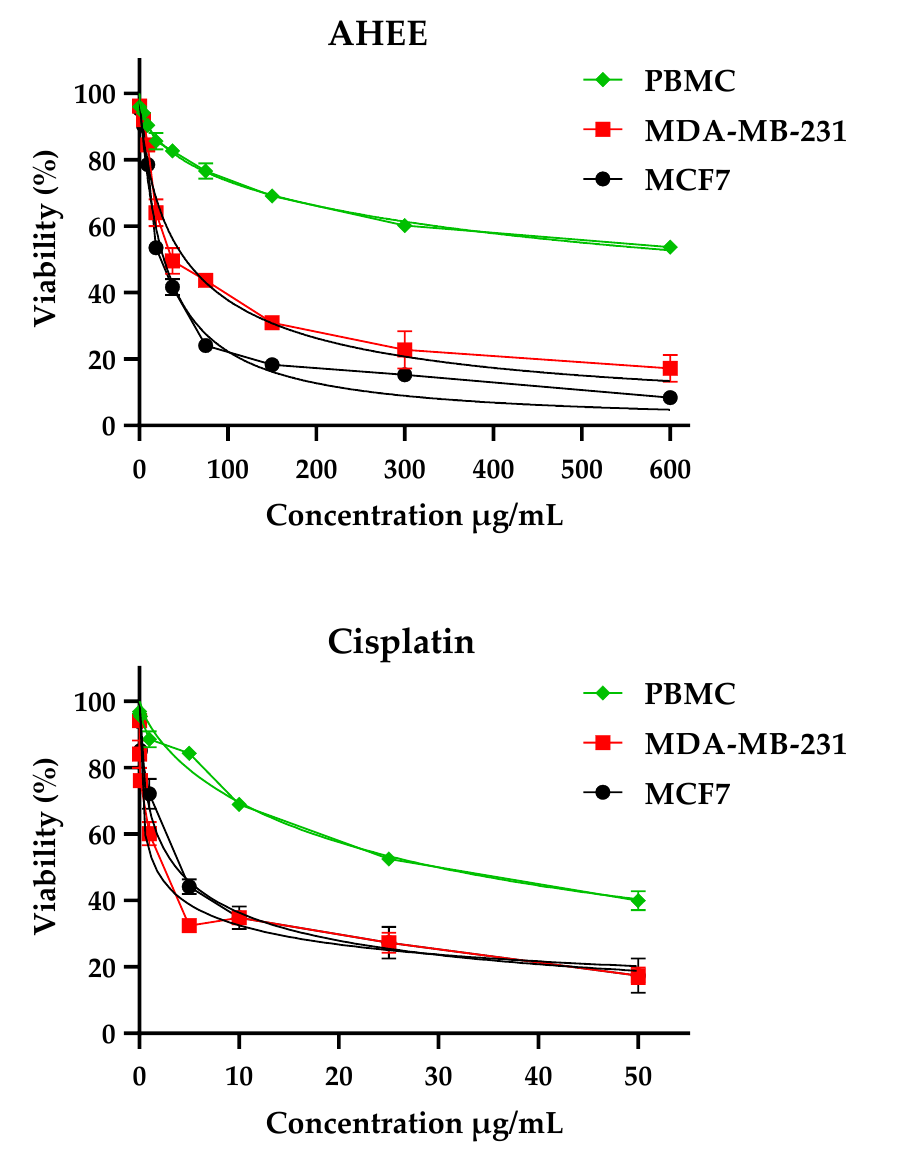
Figure 5. Cell viability of MCF-7, MDA-MB-231, and PBMC cells after 72 h of treatment with A. halimus ethanolic extract and cisplatin using MTT test.